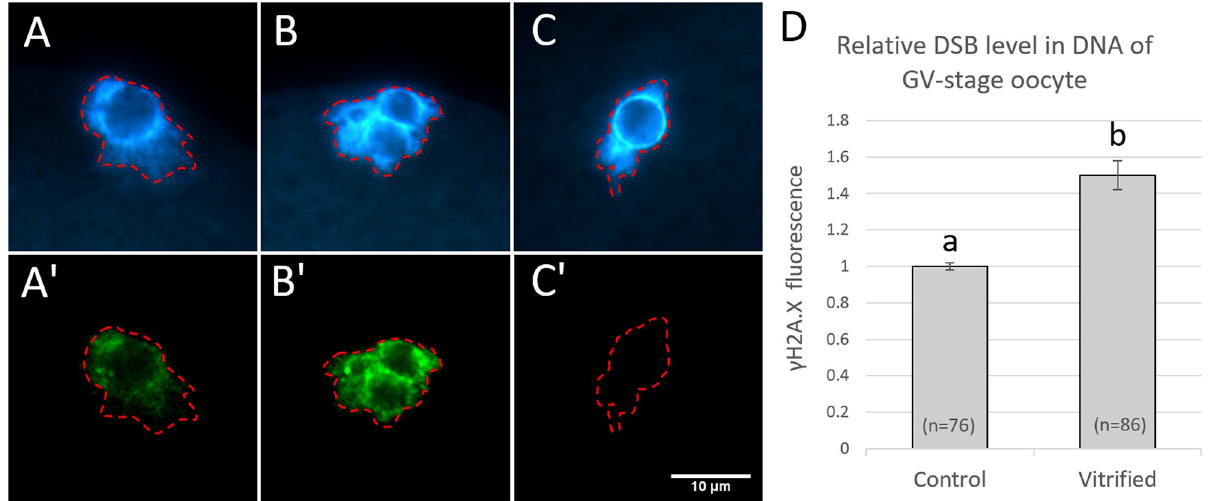
Fig 1. Fluorescent of images of DNA (blue, A-C) and the DSB marker γ H2AX (green, A’-C’) in GV-stage oocytes and relative DSB levels in the DNA of oocytes (D) without and after vitrification and warming. A-A’: freshly collected GV-stage oocyte without vitrification; B-B’: a freshly collected GV-stage oocyte after vitrification and warming (note increased γ H2AX fluorescence and the fragmentation of the nucleolus); C-C’: a GV stage oocyte processed without anti- γ H2AX (negative control). γ H2AX measurement area is highlighted with red dashed line. The scale bare represents 10 μ m. Data are shown as mean ± SEM. Values with different superscripts (a and b) differ significantly (P < 0.05). The experiment was replicated five times. Total number of oocytes in each group are given in